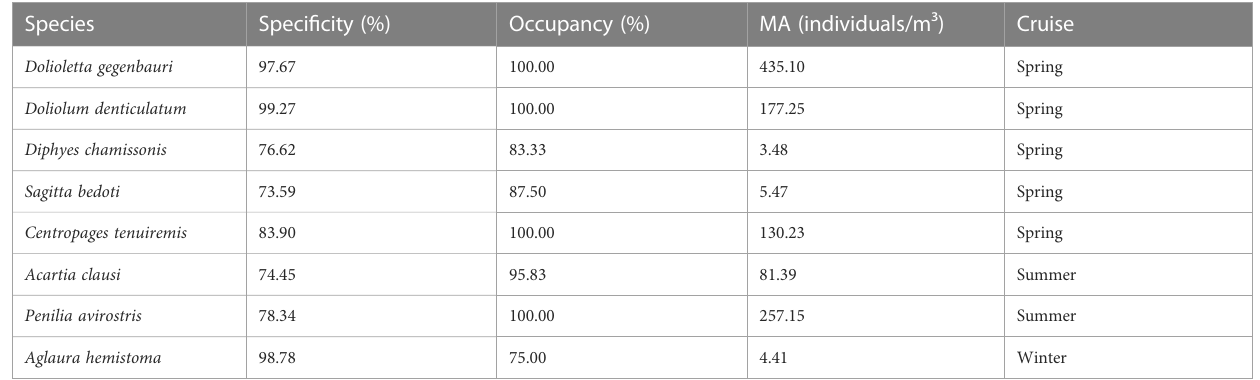
TABLE 3 Mean abundance (MA), speci fi city, and occupancy of indicator species. Species